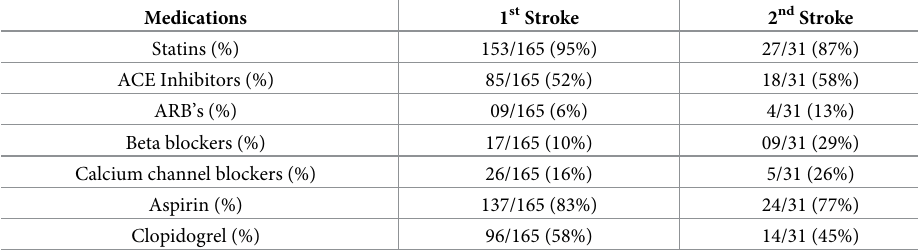
Table 2. Percentage of patients on different